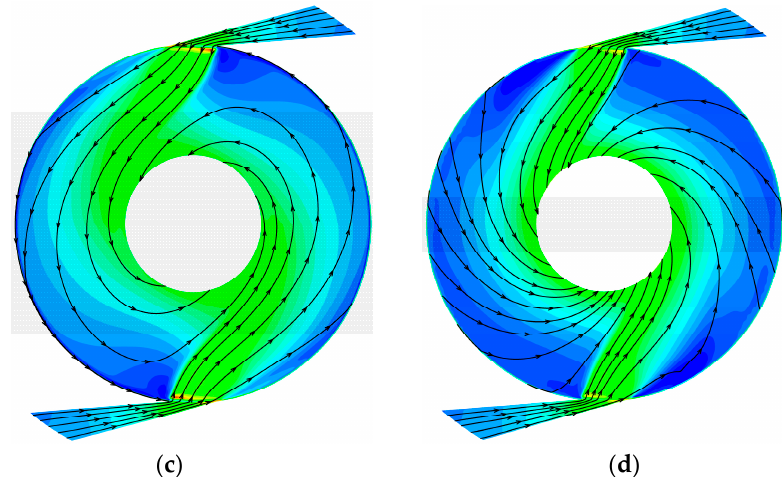
Figure 12. Streamlines and Mach number distributions on the middle of DC1 and DC3 for the one-to-many turbine models with different disc tips. ( a ) DC1 for OTM-B; ( b ) DC3 for OTM-B ;( c ) DC1 for OTM-T-2;( d ) DC3 for